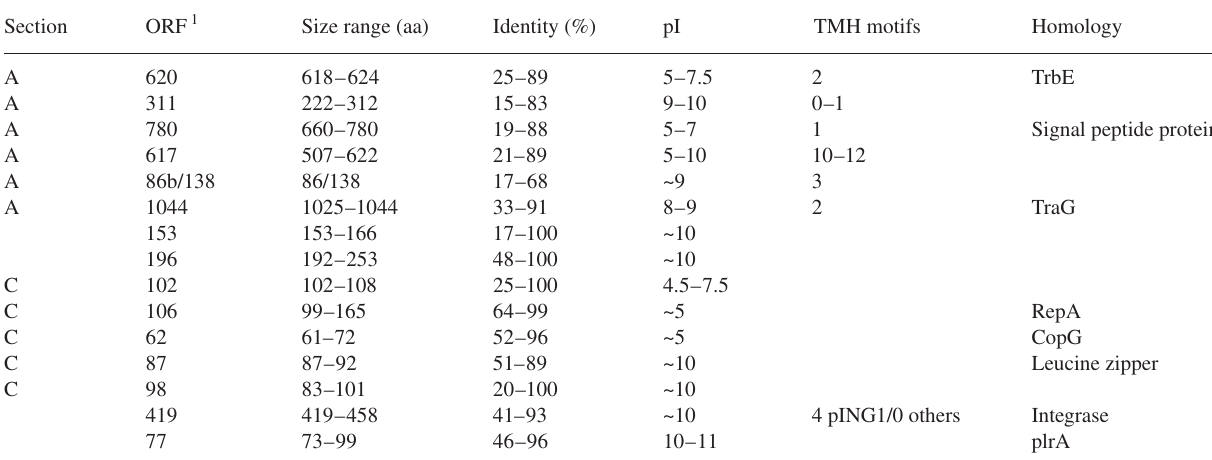
Table 2. Genes conserved in each of the Sulfolobus self-transmissableplasmids. Abbreviations: ORF = open reading frame; aa = amino acids; pI = isoelectric point; and TMH = transmembrane